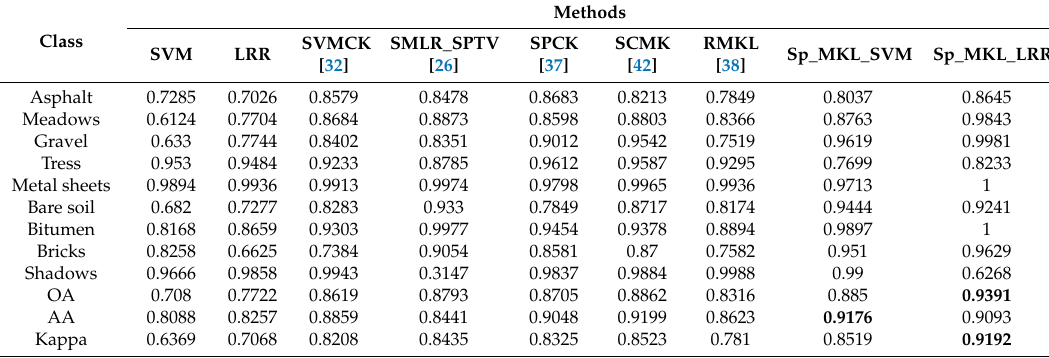
Table 2. The classification results on University of Pavia